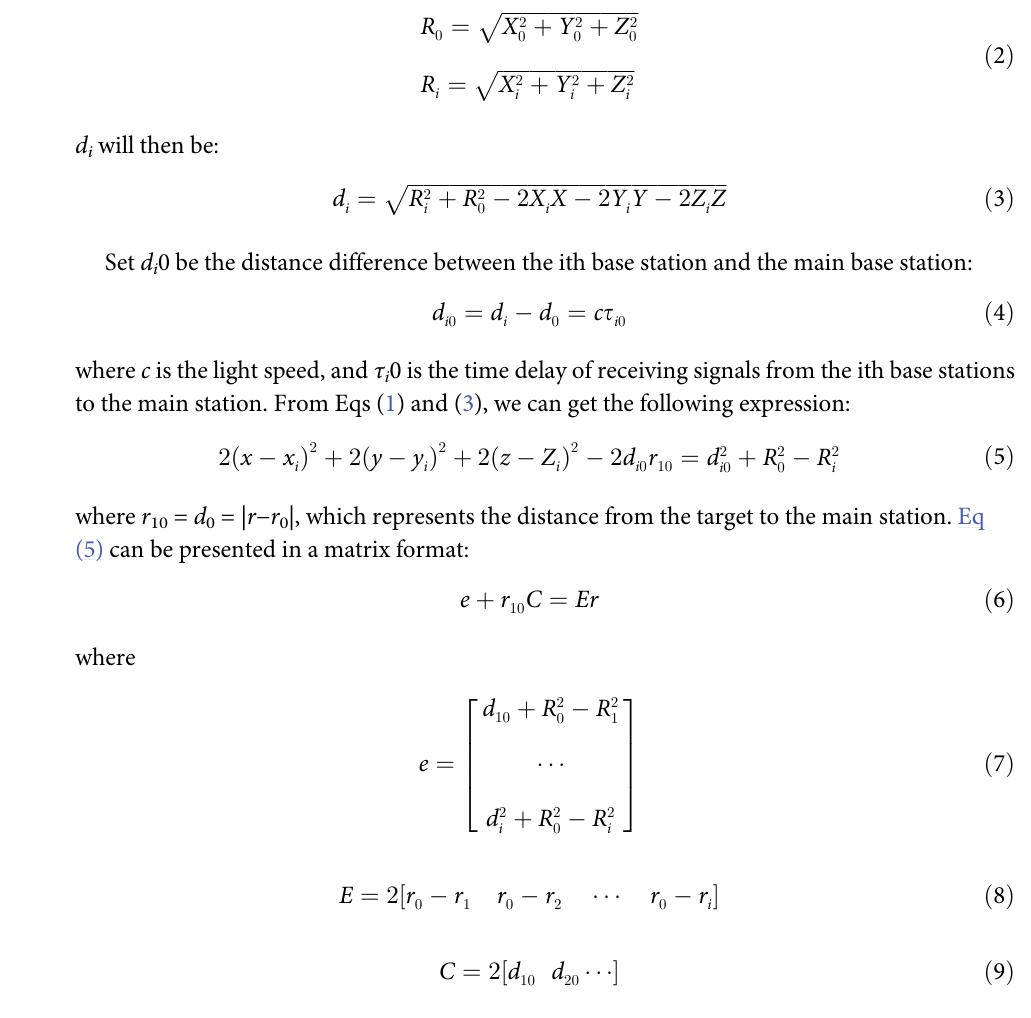
p ffiffiffiffiffiffiffiffiffiffiffiffiffiffiffiffiffiffiffiffiffiffiffiffiffiffiffi þ Y 2 X 2 0 ffiffiffiffiffiffiffiffiffiffiffiffiffiffiffiffiffiffiffiffiffiffiffiffiffiffiffi þ Y 2 X 2 i